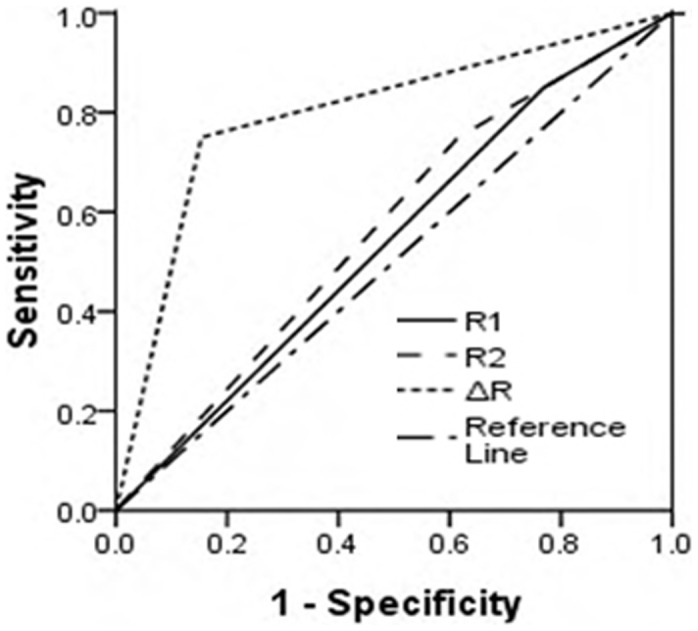
The area under the curve of ROC for R1, R2 and ΔR.AUC for R1 = 0.417, SE = 0.109; AUC for R2 = 0.683, SE = 0.095; AUC for ΔR = 0.831, SE = 0.077. The diagnostic accuracy of the ΔR was statistically significantly better than that of R1 and R2 (P<0.05).